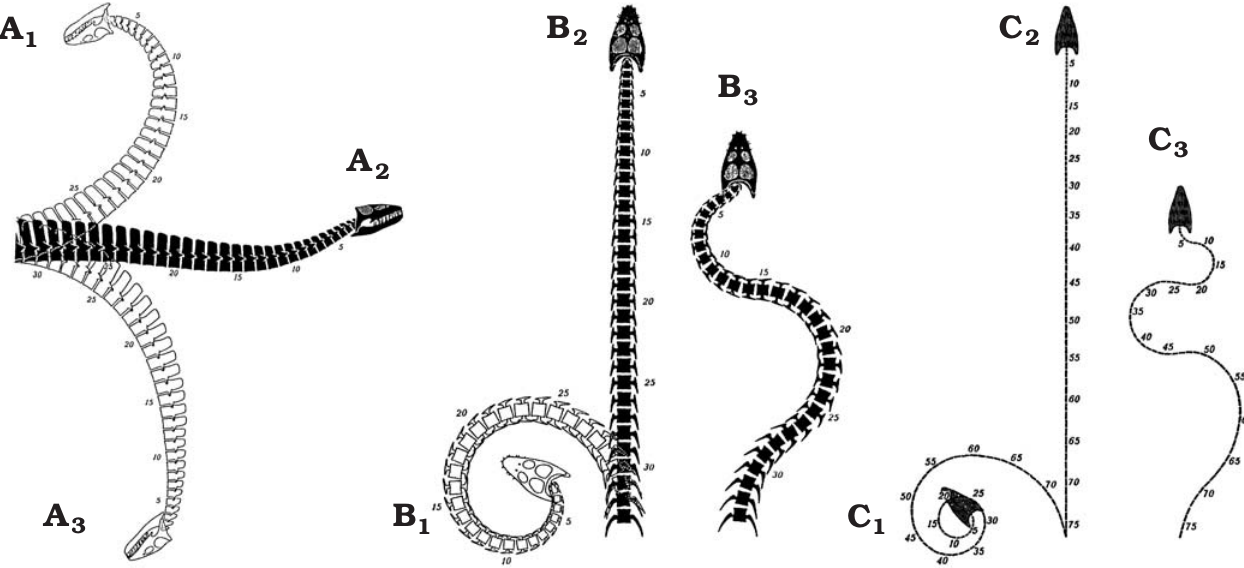
Fig. 9. The range of movement available to the plesiosaur neck in Seeleyosaurus (formerly Plesiosaurus guilelmi imperatoris ) (A, B) and Elasmosaurus (C) as illustrated by Zarnik (1925–1926), which is radically different from that proposed in the present paper. A . Right lateral view showing neutral posi- tion (A 2 ), interpreted maximum dorsal (A 1 ) and ventral (A 3 ) flexion. B , C . Dorsal view, showing the neutral position (B 2 , C 2 ), extreme left lateral flexion (B 2 , C 2 ), and maximum sinusoidal alternating lateral flexion (B 3 , C 3 ). Images from Zarnik (1925–1926: figs.